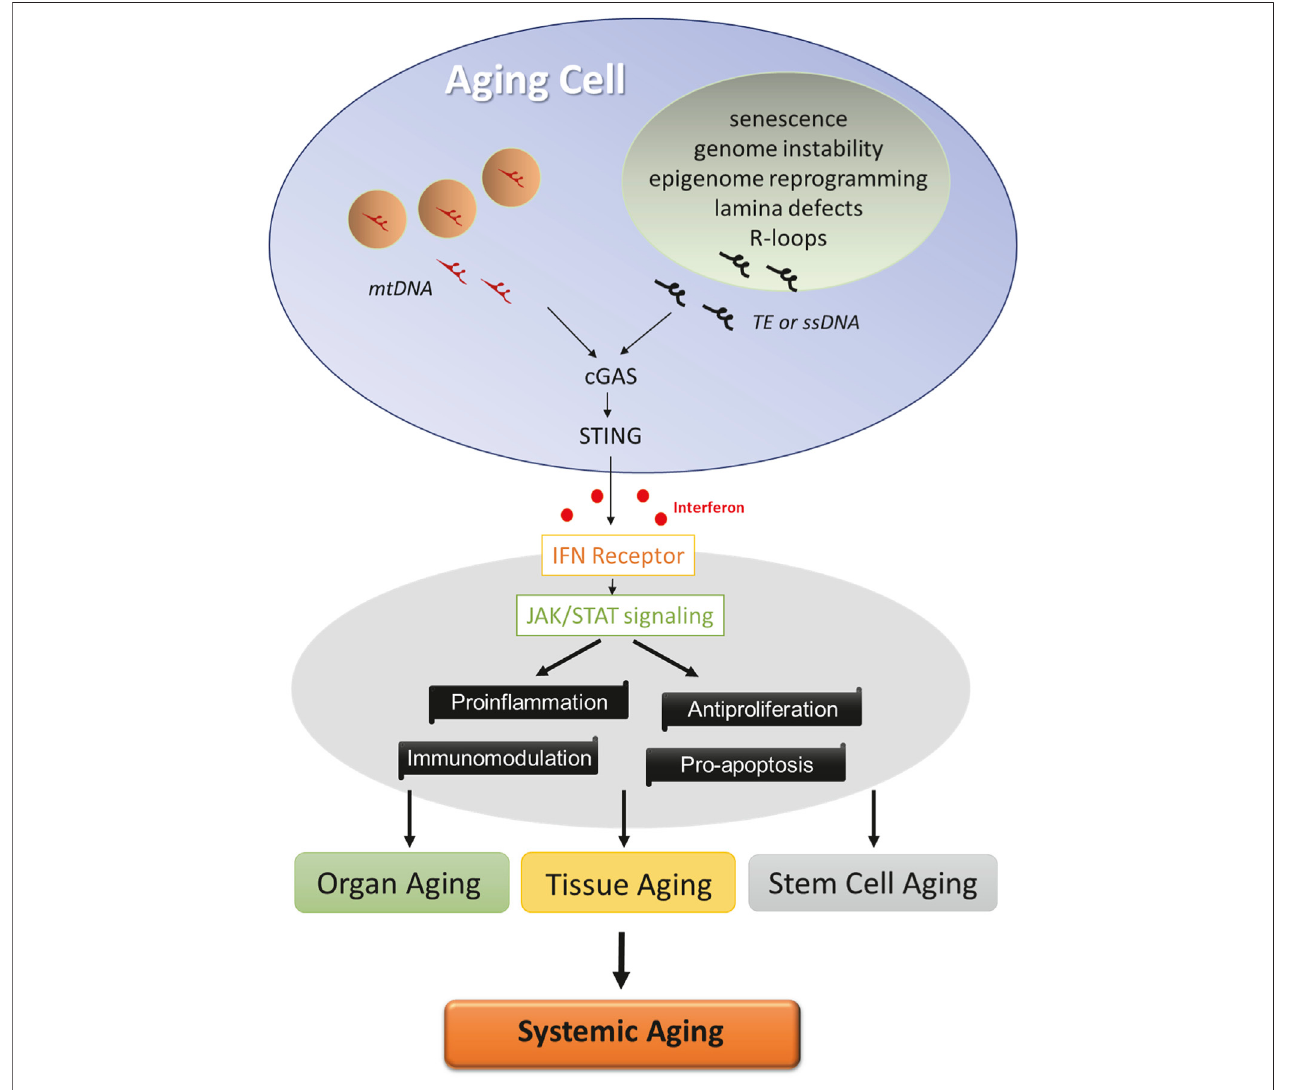
FIGURE 1 | Factors driving age-related IFN response. Cells undergo multiple molecular changes in the nuclei (green) and mitochondria (pink) during aging. CytosolicsensingofTE,ssDNA,ormitochondrialDNAbycGASactivatesSTINGandinitiatesinnateinterferonresponseinagingcells.Interferonsignaling via JAK/STAT pathway exerts a profound in fl uence on cellular functions, and its activation constitutes a core program of tissue, organ, and stem cell aging, which likely contributes to the systemic aging process.